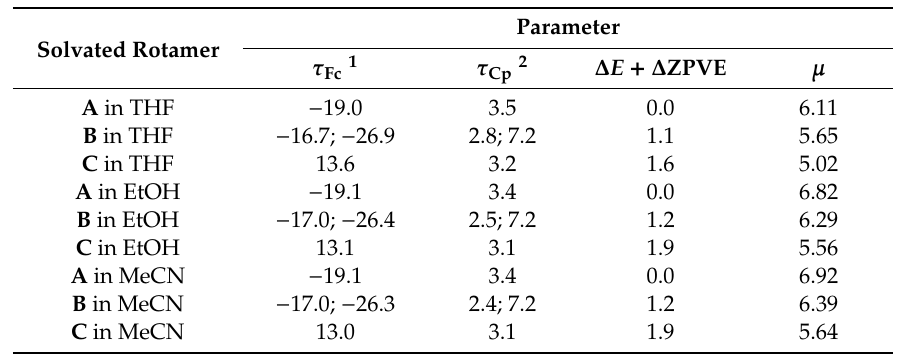
Table 7. Selected geometrical ( τ Fc , τ Cp , in ◦ ), energetic ( ∆ E + ∆ ZPVE, in kcal mol − 1 ) and electric ( µ , in D) parameters for three rotamers of Fc 2 CS solvated in tetrahydrofuran (THF), ethanol (EtOH) and acetonitrile